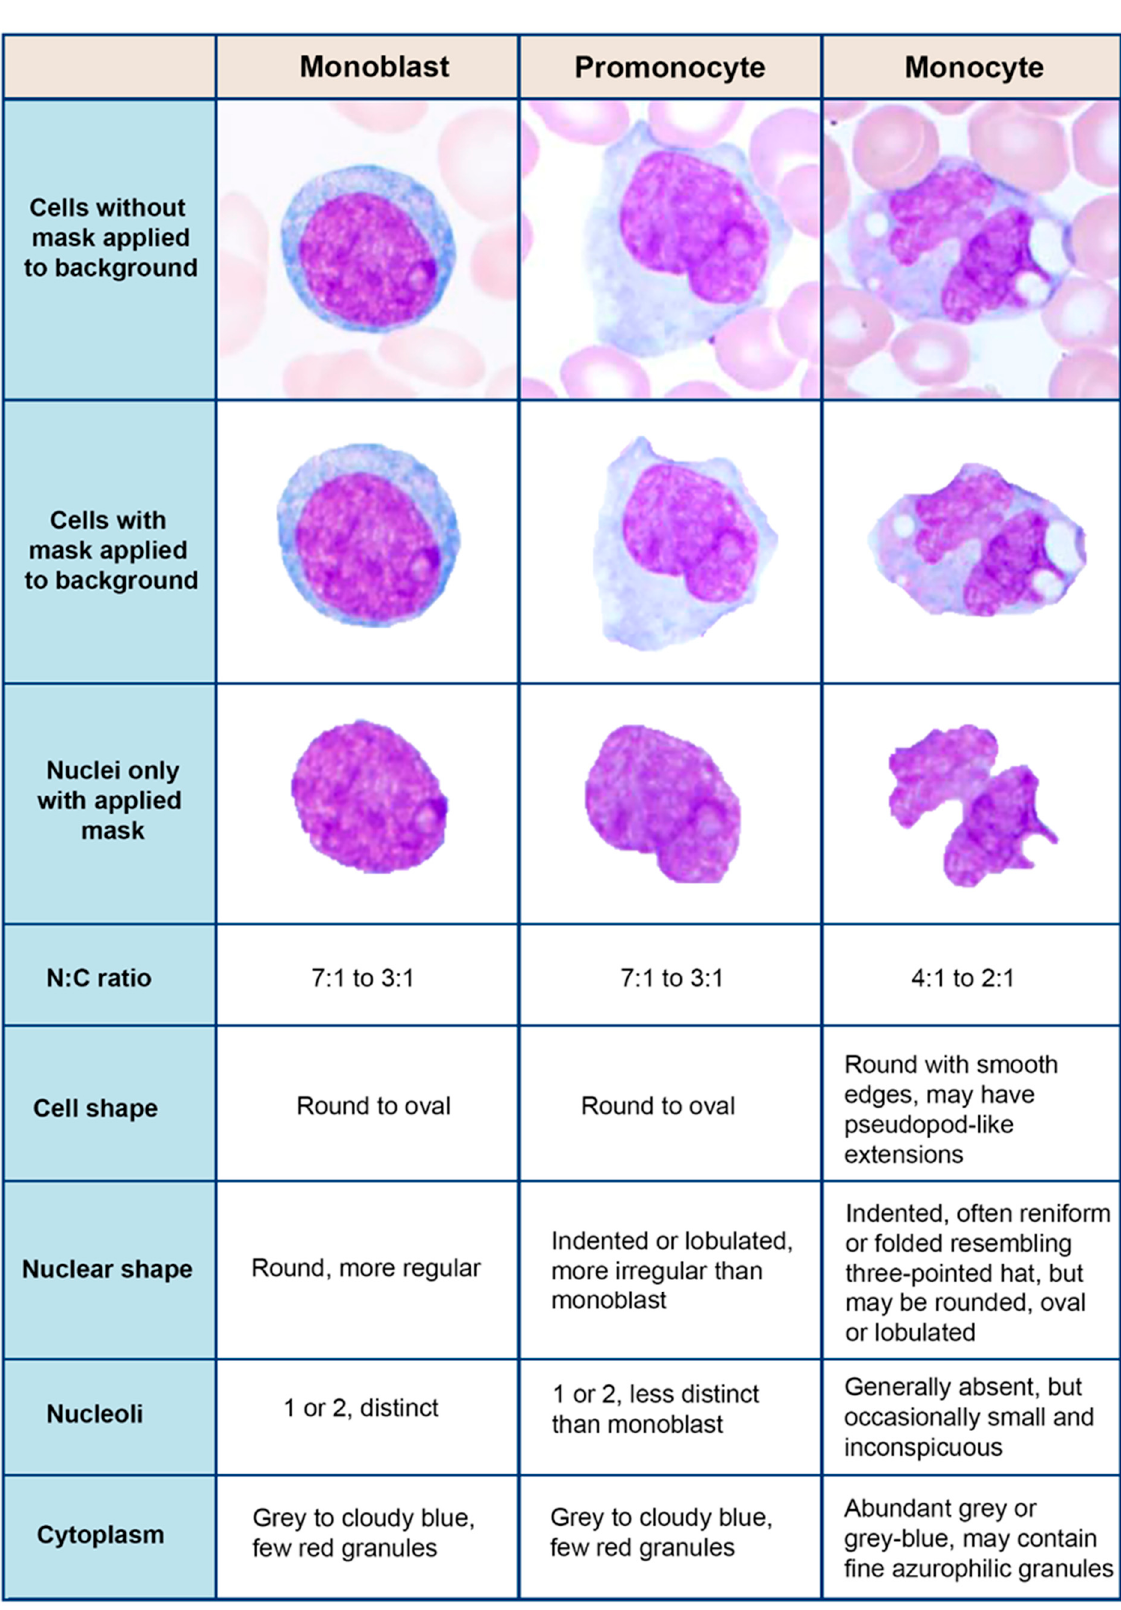
Figure 1. Examples of monocytes, promonocytes, and monoblasts with criteria.